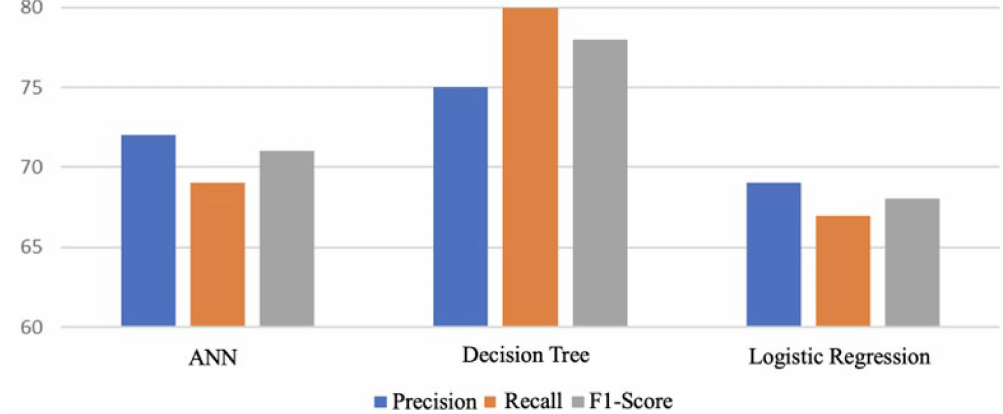
Figure 10. Comparison of Metrics for Class “1” Classification.